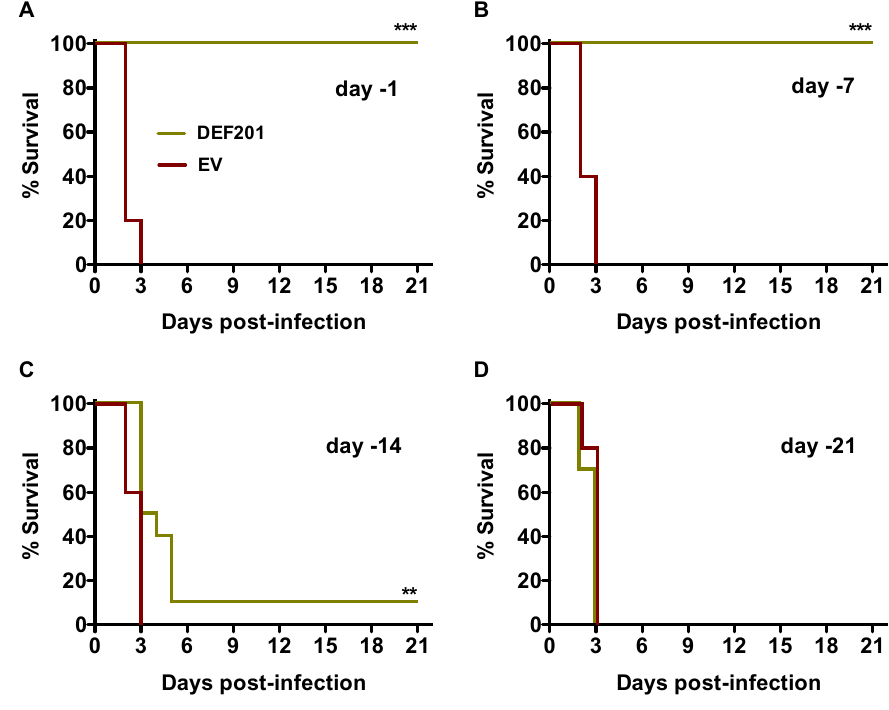
Figure 1. Pre-exposure prophylaxis with DEF201 protects hamsters from lethal s.c. RVFV challenge. Hamsters in each experimental group (n = 10) were treated i.n. with 10 8 PFU of DEF201 or empty vector (EV) on ( A ) day −1, ( B ) day −7, ( C ) day −14, or ( D ) day −21 relative to the time of infection with 30 PFU of RVFV. Kaplan-Meier survival curves are shown. ** p < 0.01, *** p < 0.001 compared to respective EV